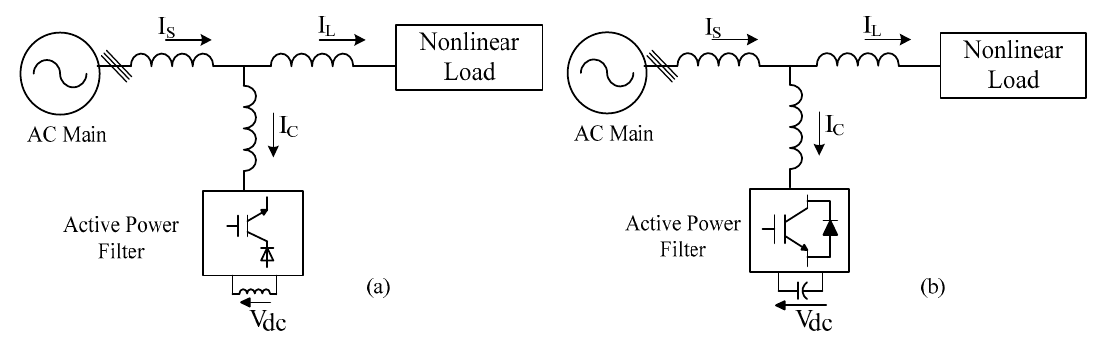
Figure 6. ( a ) Current-fed- and ( b ) voltage-fed-type inverters.